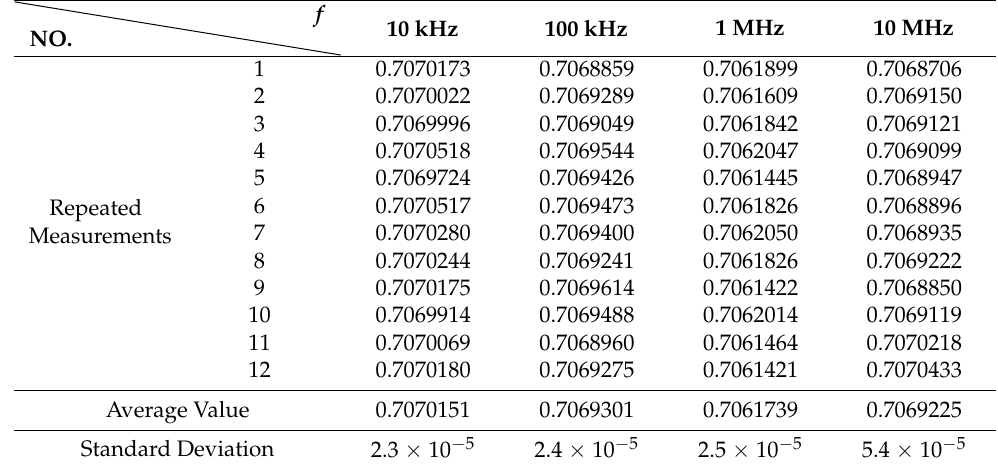
Table 1. RMS measurement